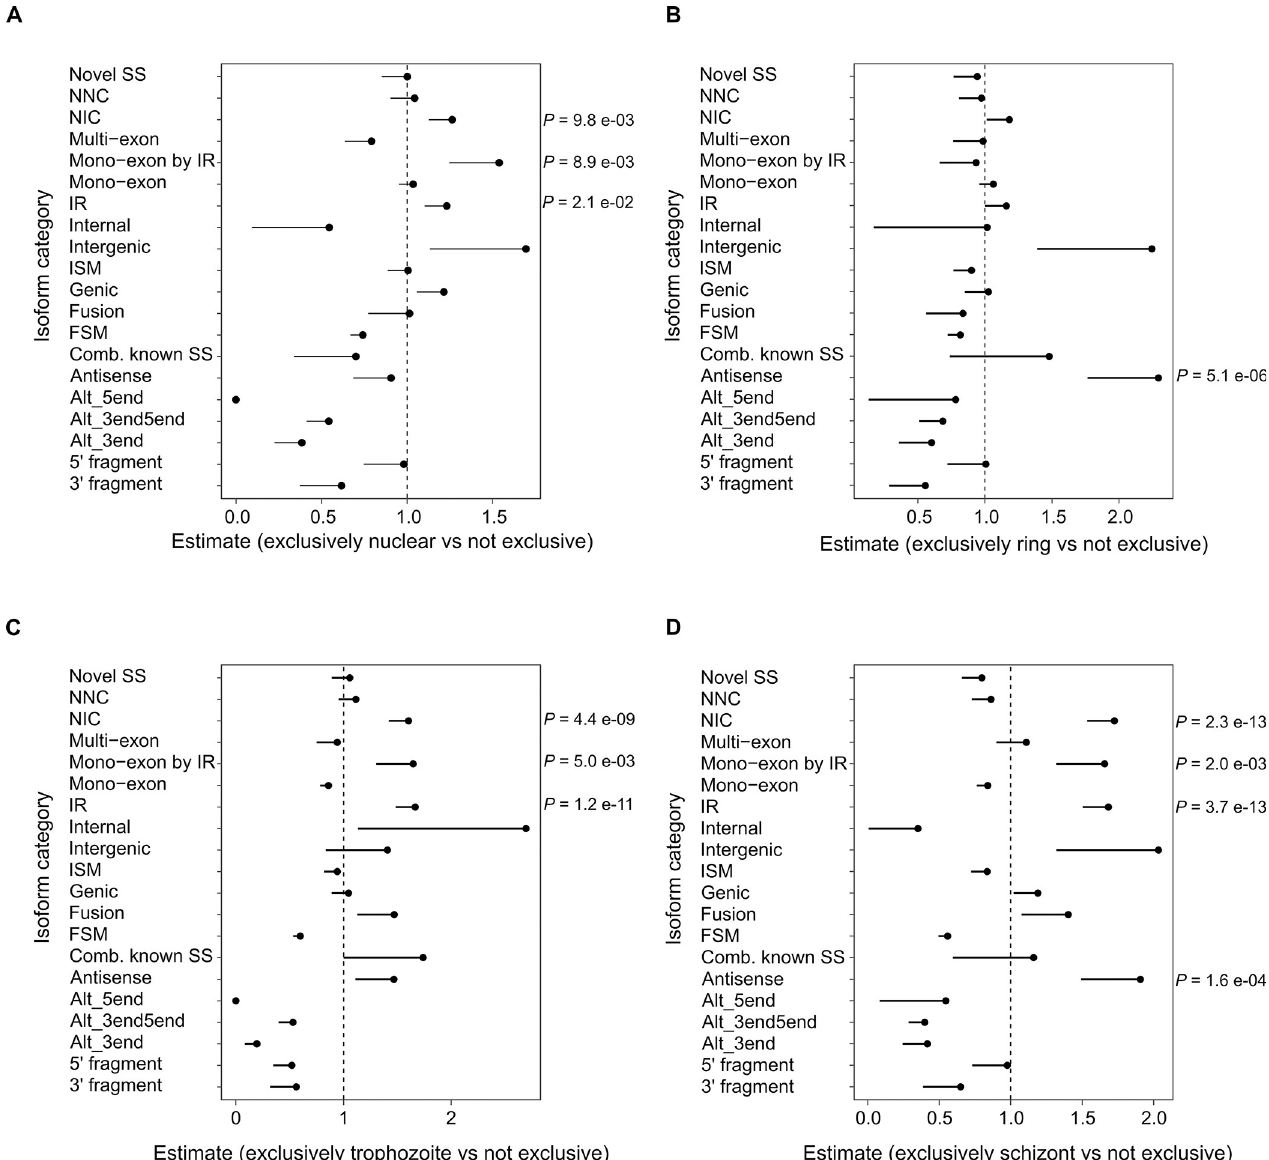
Fig 6. Over-representation of novel isoform types in the nucleus and across developmental stages. Counts were made of 11,325 Plasmodium falciparum 3D7 novel isoforms assigned to structural categories by SQANTI3 [35] supported by PacBio data in this study (S2B Table). Counts in each category were analyzed by one-tailed Fisher’s exact test. Plots of odds ratio for each test are shown; for odds ratios significantly greater than 1 (dashed line), the Holm- Bonferroni adjusted P -values are indicated on the right of each plot. The lower confidence interval is indicated for each odds ratio by a solid line. (A) Isoforms represented exclusively nuclear vs not exclusive. (B) Isoforms represented exclusively ring-stage vs not exclusive. (C) Isoforms represented exclusively trophozoite-stage vs not exclusive. (D) Isoforms represented exclusively schizont-stage vs not